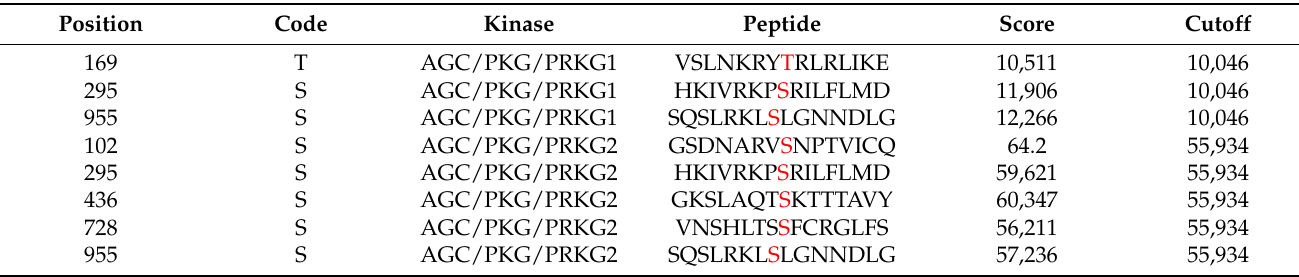
Table 1. Potential sites of PKG I and II -mediated phosphorylation in NLRP3